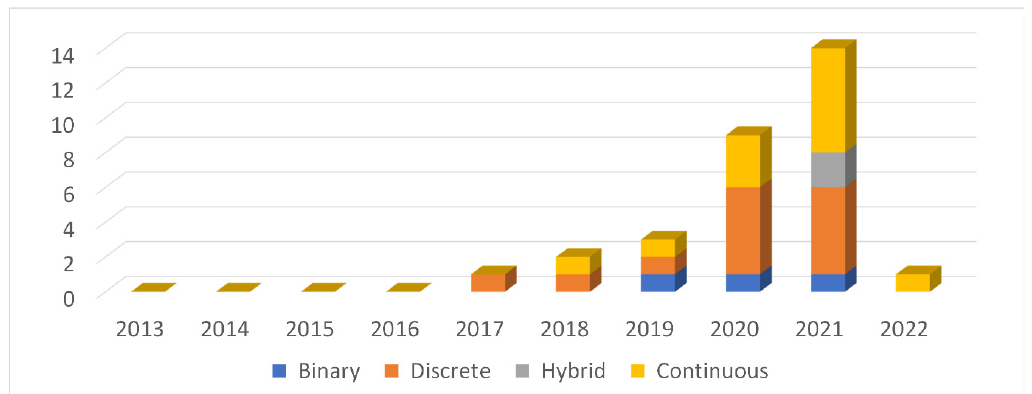
Figure 8. Distribution of works on interdependent zones according to Tier 2 categories.